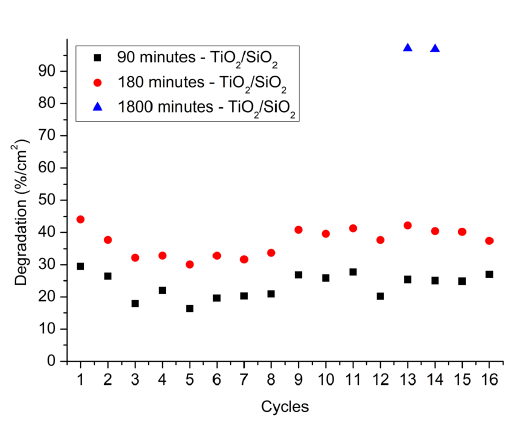
Figure 6. Results of 16 cycles of photocatalysis tests, comparing the degradation rates (%/cm 2 ) at 90 (black squares), 180 (red circles), and 1800 minutes (blue triangles) of exposure to UV light irradiation, made to evaluate the photocatalytic stability of the TiO film deposited by sputtering on a silica glass substrate.